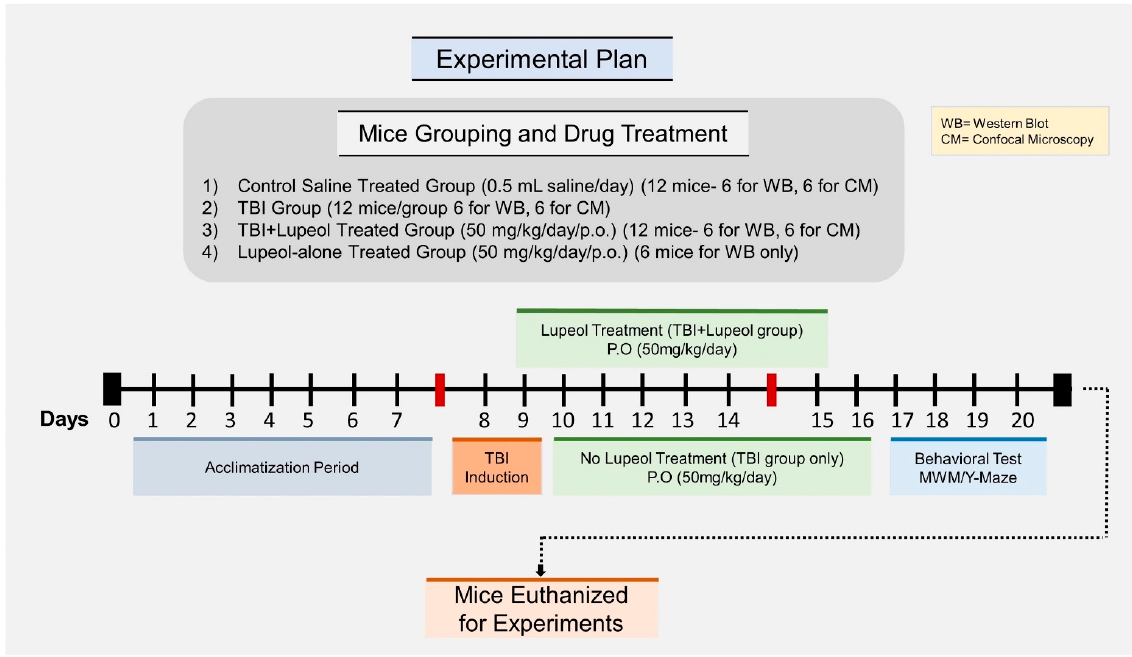
Figure 7. Schematic diagram of the experimental design showing the duration of the TBI and/or lupeol administration in adult mice and the behavioral